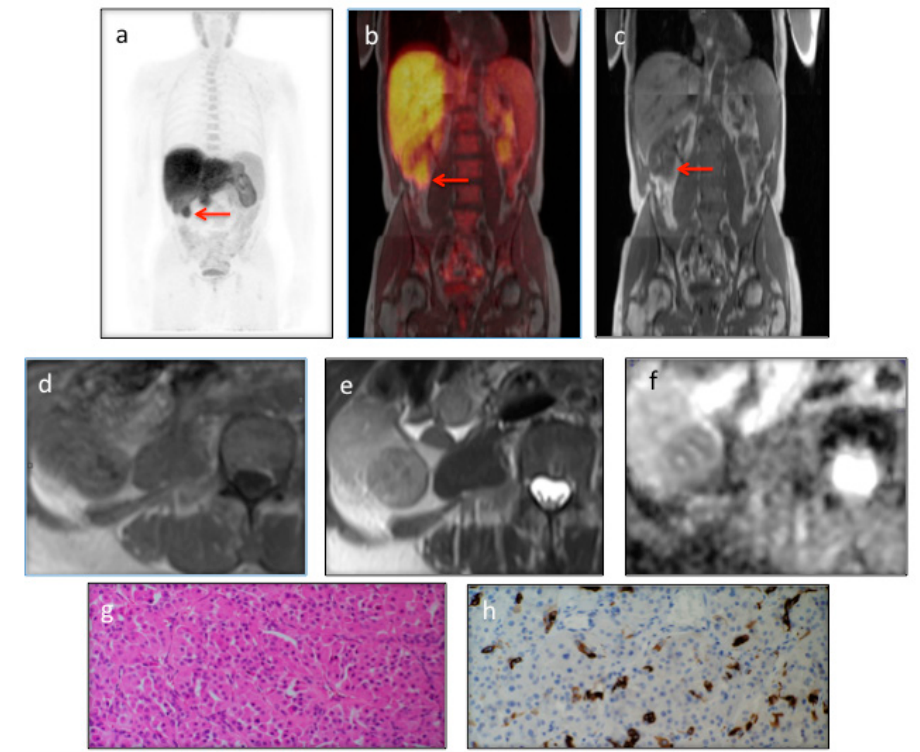
Figure 1. PET/MRI is a new hybrid imaging modality, which has recently been introduced into clinical practice [1]. We present a 79 year-old gentleman with a past history of prostate cancer Gleason 6 (3 + 3) treated with brachytherapy who underwent a re-staging 18 F-Choline PET/MRI scan following a rise in PSA (4.07, nadir 1.3). Apart from an abnormal focus at the base of the left seminal vesicle, which was suspicious for disease recurrence, the 18 F-Choline PET/MRI showed intense tracer uptake within a solid 34 mm right lower pole renal mass ( a – c , red arrows), with MRI features typical for an oncocytoma: iso/hypo intense signal on T1-weighted ( d ); hyperintense on T2-weighted ( e ); and central area of low signal intensity on both T1-weighted and T2-weighted images suggestive of a central scar ( d , e ); The lesion appeared hindered on high b value ( b -value = 900 s/mm 2 ) diffusion weighted sequences ( f ). A right laparoscopic radical nephrectomy was performed subsequently. Macroscopically, a lower pole tan-coloured tumour was present. Sections of the tumour showed an encapsulated lesion comprised of packets of oncocytic cells staining positively for CK7, in keeping with an oncocytomas ( g (200 ˆ magnification) and h (400 ˆ magnification)). The differentiation of an oncocytoma from other solid renal lesions, in particular renal cell carcinoma (RCC), is a diagnostic challenge [2]. MRI is frequently used for the detection and differentiation of renal masses, including oncocytomas. However the specificity of MRI is reduced since the features of oncocytomas show considerable similarities with those of RCCs [3]. Diffusion-weighted imaging (DWI) can augment MRI characterisation of renal lesions, but there is an overlap in the ADC values of RCCs and oncocytomas. Different authors have shown that malignant renal tumours have lower ADC values when compared to benign tumours such as oncocytomas [4]. However, other studies have demonstrated similar ADC values for these two tumour types [5]. PET/MRI maximises the diagnostic information available. This particular case demonstrated its value in the characterisation of an incidental renal lesion, thus avoiding the need for further diagnostic tests and potentially reducing unnecessary surgical resections. Choline-avid oncocytomas have not been described before, but cannot be differentiated from renal cell carcinomas on the PET characteristics alone. The addition of MRI features led to a confident PET/MRI diagnosis of an oncocytoma. All procedures performed in this study were in accordance with the ethical standards of the institutional and/or national research committee.